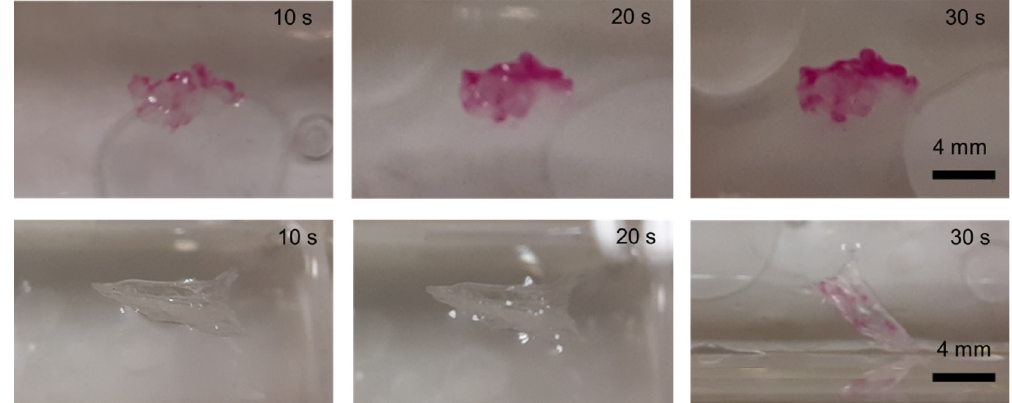
Figure 7. Time-lapse images indicating the color change of the hydrogel doped with phenolphtalein, as a floating pH meter for NH 3 ( upper ) and NaOH ( bottom ) solutions.